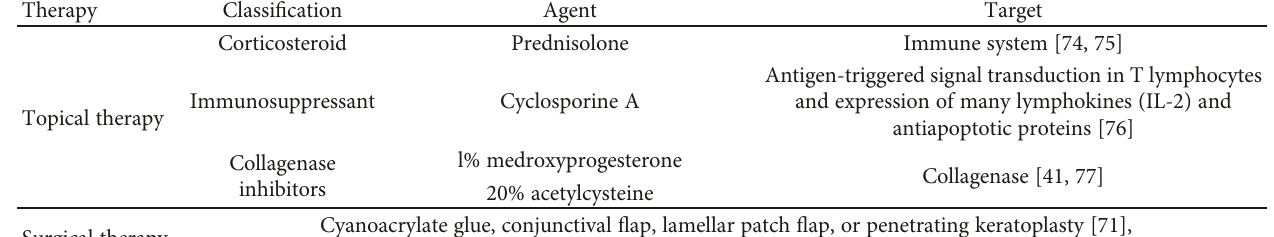
Table 1: The therapy of PUK associated with autoimmune